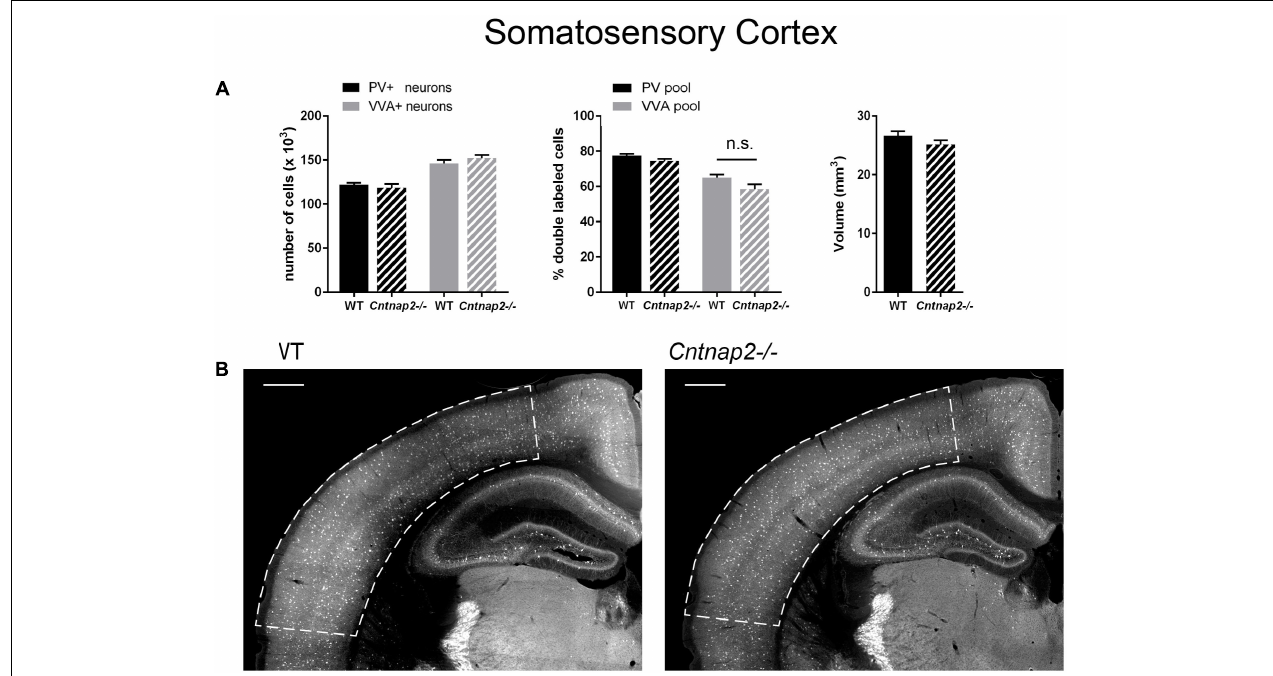
FIGURE 3 | (A) Left: Stereological estimations of PV + (black) and VVA + (gray) cells in the SSC of PND25 WT ( N = 6) and Cntnap2–/– ( N = 5) mice. Middle: percentage of PV + cells surrounded by VVA (black) and VVA + cells showing PV expression (gray) in WT and Cntnap2–/– mice. Right: Volume of the ROI; i.e., the SSC. (B) Representative PV immunofluorescence images from the SSC of a WT and Cntnap2–/– mouse. ROIs are indicated with dashed lines (sections are located at Bregma –1.34 mm). Scale bar: 500 µ m. All data are expressed as mean ± SEM.